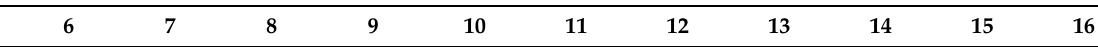
Table 2. Means, standard deviations, and correlations for study variables ( N =